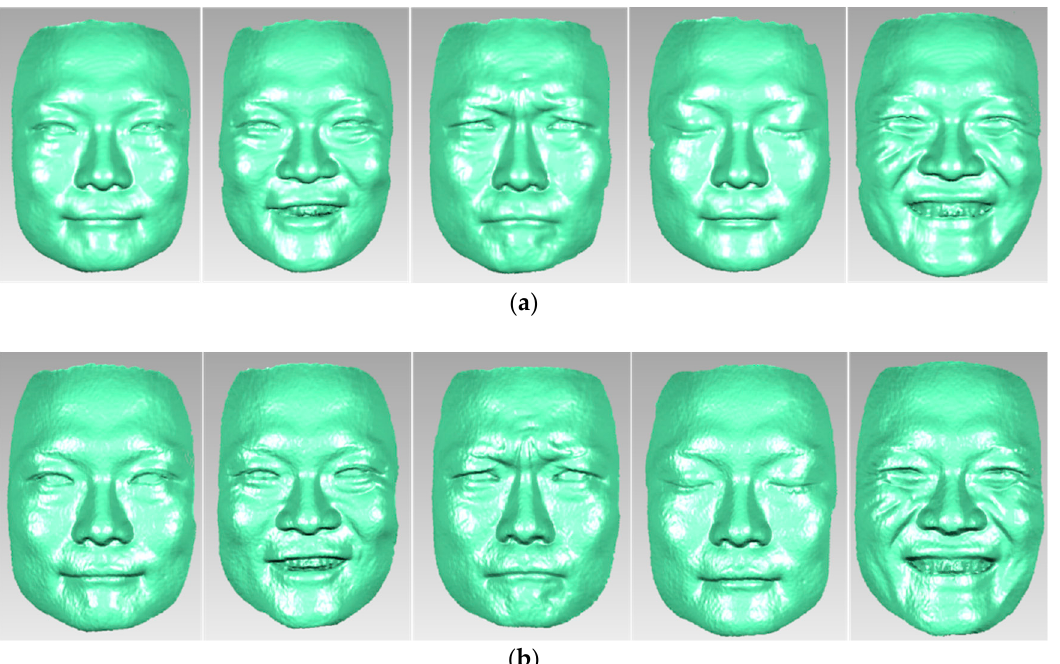
Figure 13. Comparison of real human face reconstruction respectively using ( a ) STMCF (N = 12); ( b ) STZNCC (N =